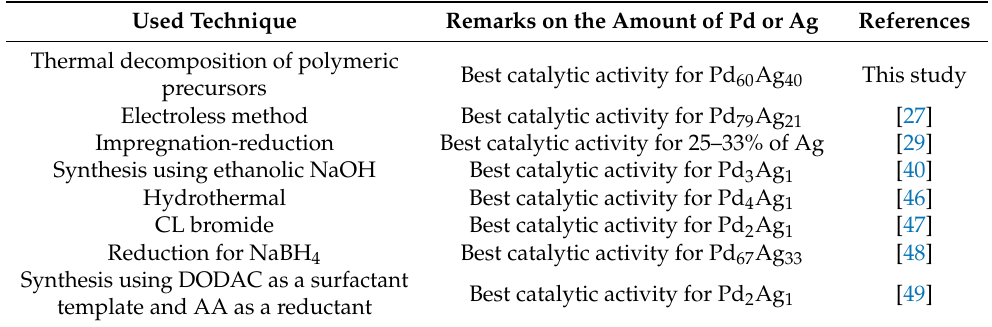
Table 6. Comparison between some PdAg electrocatalysts presented in the literature with Pd 60 Ag 40 /C evaluated in this